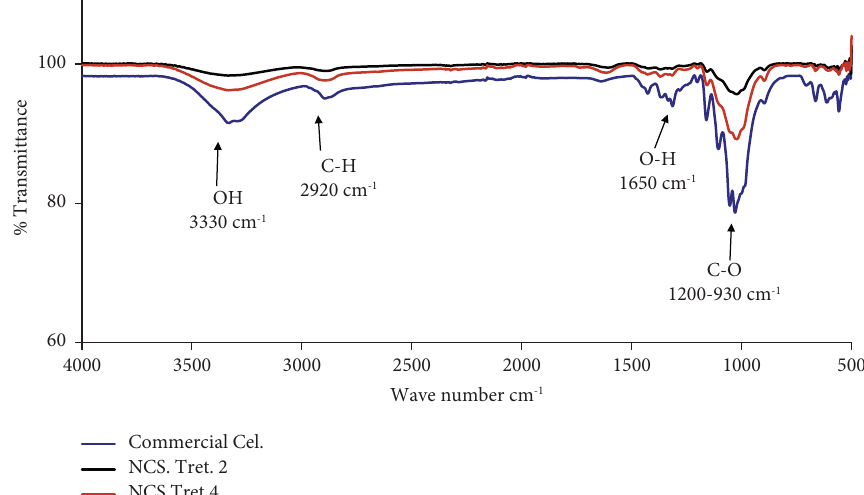
Figure 4: Nanocellulose comparison obtained by enzymatic hydrolysis (NC) from rice husk, characterized by Fourier transform infrared spectroscopy (FTIR). (NCS tret.2) and (NCS tret 4). (source: the author